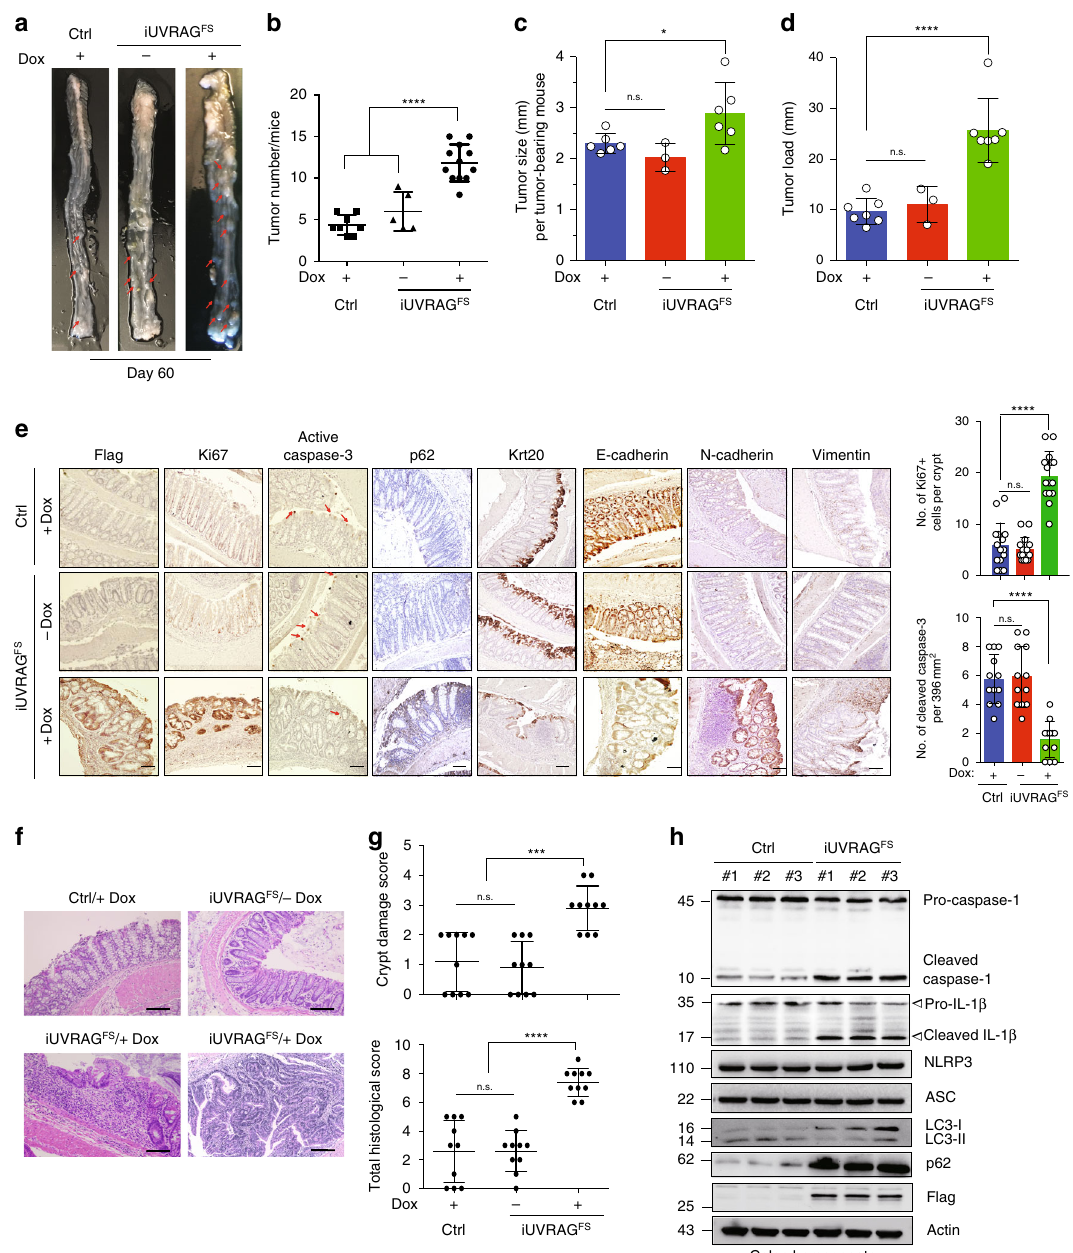
Fig. 5 UVRAG FS predisposes mice to colitis-associated colon cancer. a Representative macroscopic images of the colon from AOM-DSS-treated control (Ctrl) and iUVRAG FS mice in the presence/absence of Dox at the time of necropsy (day 60). Red arrows highlight colonic tumors. b – d The number ( b ), size ( c ), and overall load ( d ) of colonic tumors in AOM-DSS-treated mice in a . Tumor load is evaluated by totaling the diameters of all tumors in AOM-DSS- treated mice in a . n = 5 – 12 mice per genotype. e IHC staining of Ki67, cleaved caspase 3, p62, keratin 20, E-cadherin, N-cadherin, and vimentin in the colons from AOM-DSS-treated mice of indicated genotypes. Data are from one animal that is representative of 5 – 12 animals in each group. The levels of Ki67 staining (top right) and tumor apoptosis (bottom right) in the indicated colon were quanti fi ed. Arrows (red) denote cells undergoing apoptosis. Scale bars, 100 μ m. f H&E-stained sections of the colon from AOM-DSS-treated mice in a . Data are from one animal that is representative of 5 – 12 animals in each group. Scale bars, 100 μ m. g Histological scores for crypt damage (top) and total histological score (bottom) of colons from mice in a were quanti fi ed at day 60 as described in the Methods. n = 10 mice per group. h WB analysis of caspase-1 cleavage, IL-1 β production, LC3-I/II, and p62 levels in colon tissues of Dox-treated control and iUVRAG FS mice after AOM-DSS treatment. Data in h are from one experiment that is representative of three independent experiments. For all quanti fi cations, data (mean ± SD) were from the indicated number of independent experiments and analyzed with one- way ANOVA. n.s., not signi fi cant; * P < 0.05; *** P < 0.001; **** P < 0.0001. Source data are provided as a Source Data fi le. See Supplementary Fig. 9 for uncropped data of h